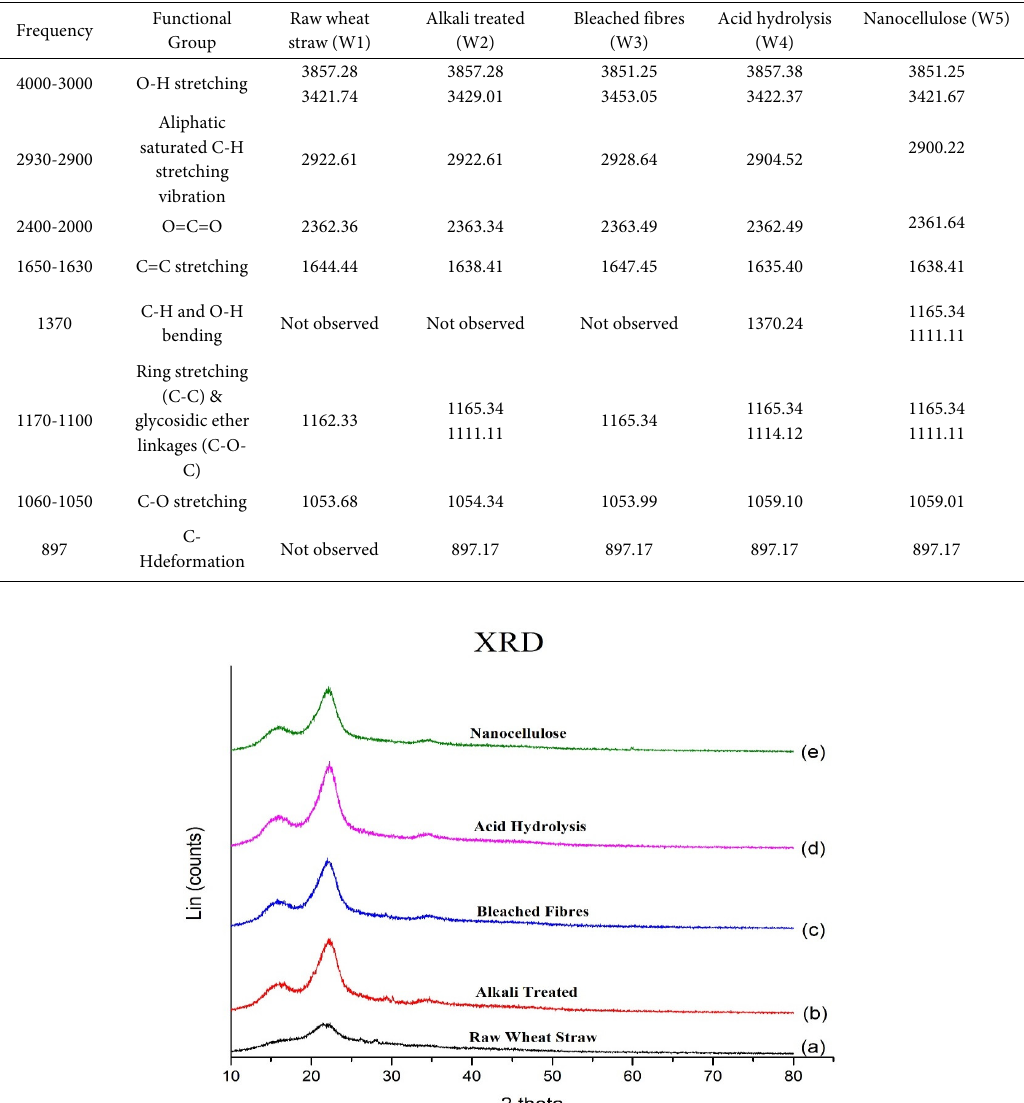
Table 3. FTIR Functional groups and their observed peaks